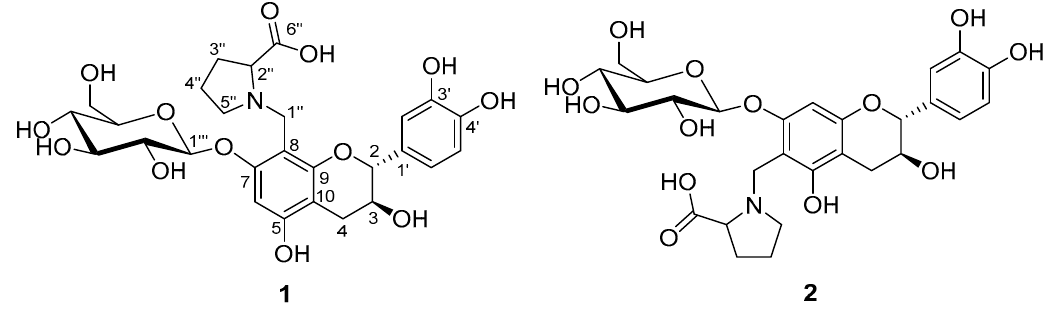
Figure 1. The structures of 1 and 2 from Codonopsis pilosula.